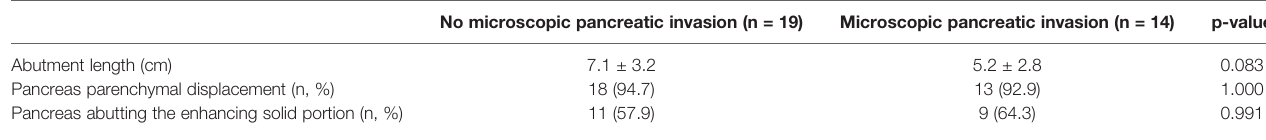
TABLE 4 | CT fi ndings according to microscopic pancreatic invasion.